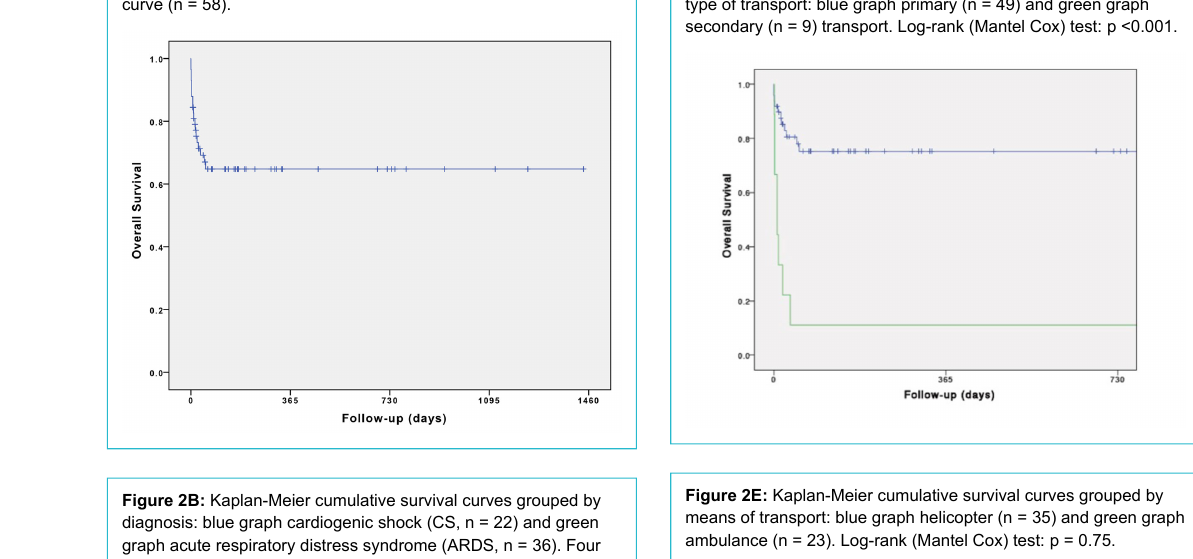
Figure 2D: Kaplan-Meier cumulative survival curves grouped by type of transport: blue graph primary (n = 49) and green graph